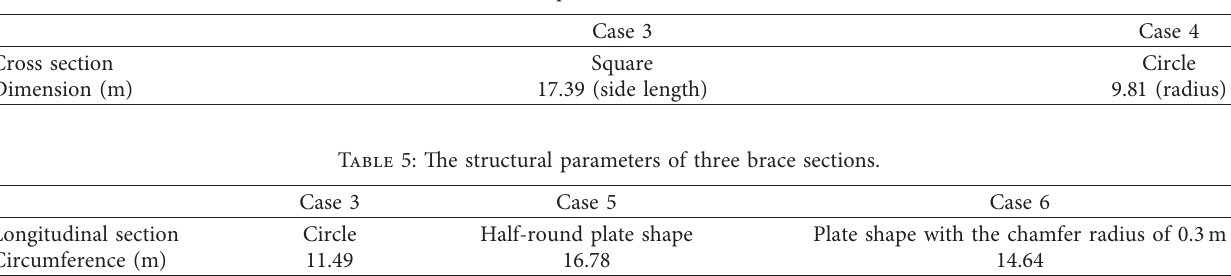
Figure 2: The platform models with three pontoon end shapes. (a) Case 1: half-round model; (b) Case 2: sharp-angle model; and (c) Case 3: rounded-cube model. Table 4: The structural parameters of two column sections.